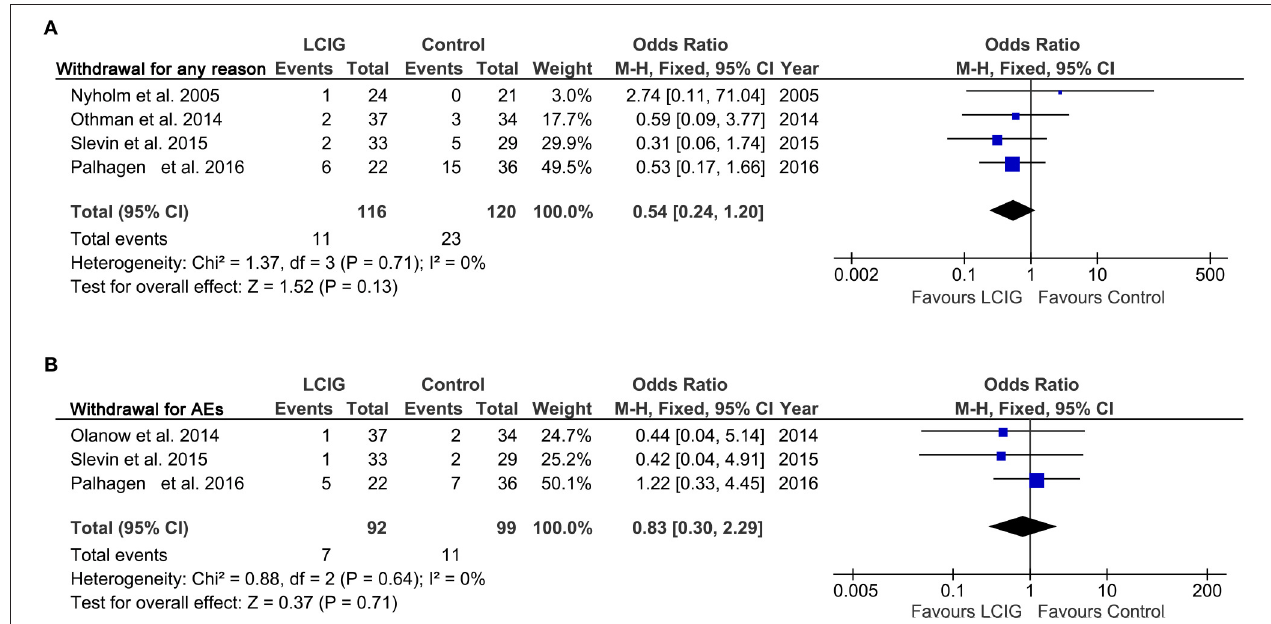
FIGURE 5 | Forest plots of pooled withdrawal in PD patients. Plot A (A) , withdrawal for any reason; plot B (B) , withdrawal for AEs. PD, Parkinson’s disease; AEs, adverse effects; LCIG, levodopa-carbidopa intestinal gel.